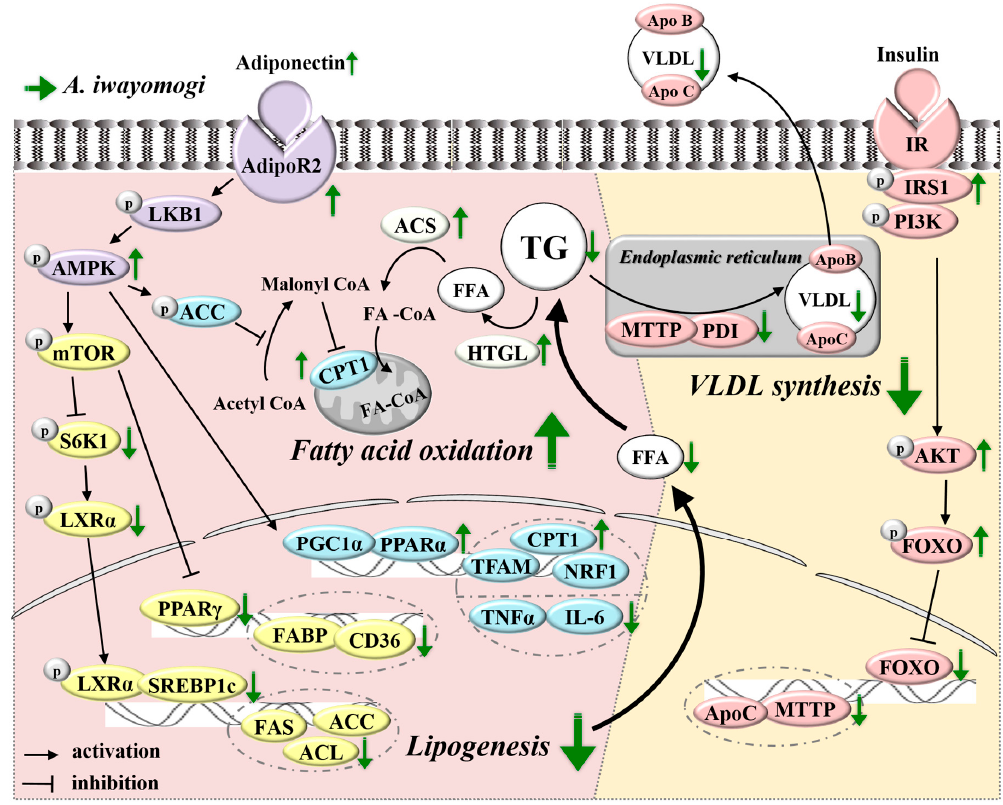
Figure 6. Schematic representation of mechanisms by which AI inhibits HFD-induced hypertriglyceridemia.